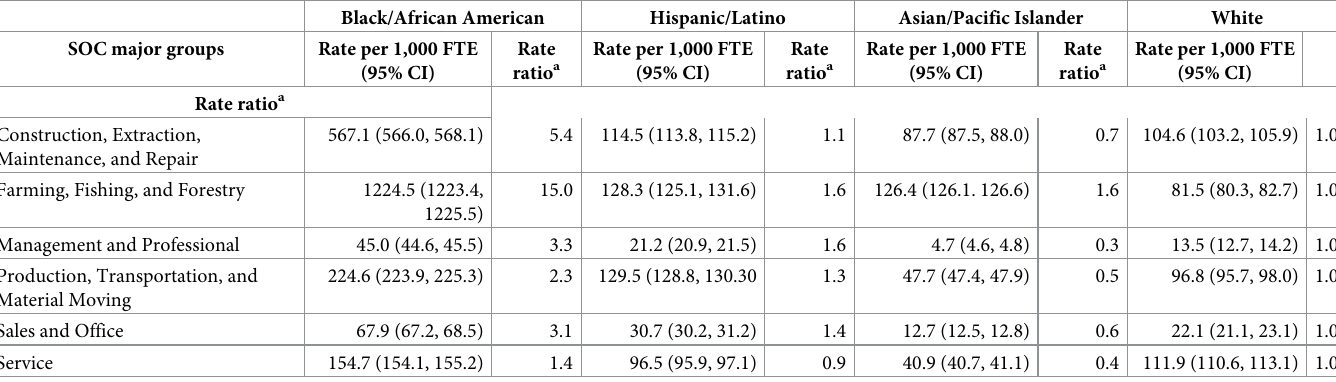
Table 3. Rates of accepted workers’ compensation claims by estimated race/ethnicity and Standard Occupational Classification (SOC) major